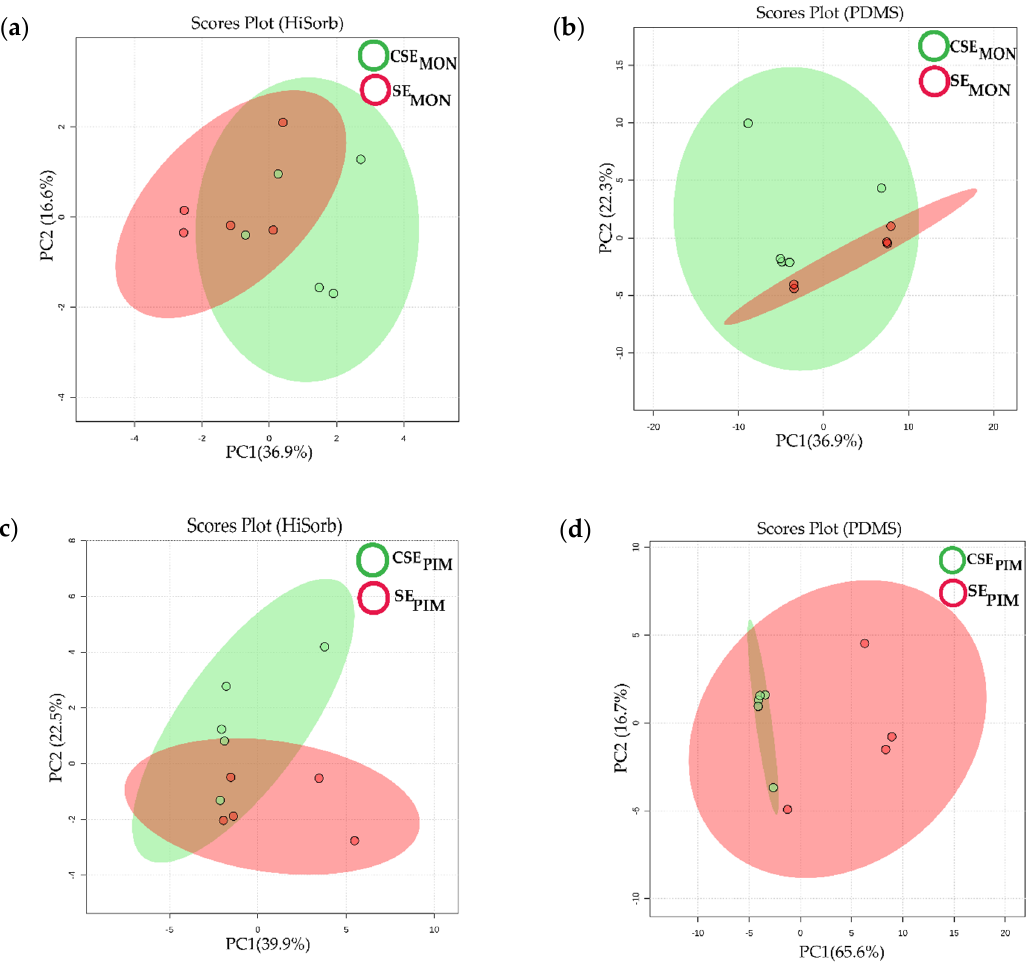
Figure 2. Differences in root volatilome profiles between stressed (SE-red) and control (CSE-green) upon 24 h leaf hebivory. Principle component (PC) plots of S. lycopersicum root volatilomes trapped with HiSorb ( a ) or PDMS ( b ) and of S. pimpinellifolium trapped with HiSorb ( c ) or PDMS ( d ). For each plot, a single coloured dot represents the volatilome of one sample. Distances between dots are equivalent to variation between replicates. The shadowed coloured cluster represents the 95% interval of confidence.